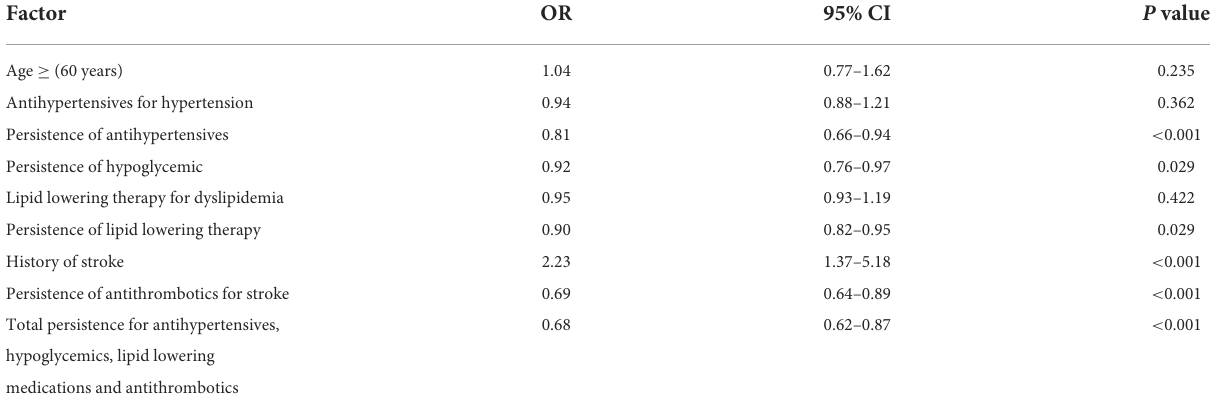
TABLE 5 Multivariable regression analysis of risk factors for new ischemic stroke during follow-up.